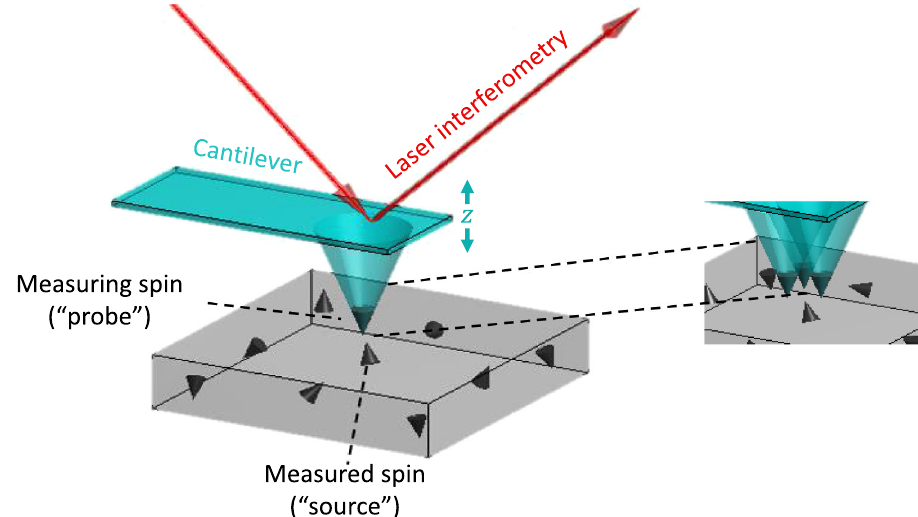
Fig. 1 A conceptual example of a magnetic near fi eld measurement system, analyzed using the principles of quantum measurements. A sample (gray) contains one or more spins to be measured (black cones). The measurement is performed on one of them at a time. The measurement device (tip) consists of spins attached to a vertically-bending cantilever (blue). The tip can contain a complex spin con fi guration, as shown in the inset on the right. Different spin con fi gurations represent different measurement setups, which are investigated to fi nd the optimal one. The measurement proceeds as follows: The tip is brought closed to the measured spin (source), such that it interacts with the tip ’ s spins (probe). The interaction exerts a force on the cantilever, yielding an (entangled) superposition of vertical displacements, each correlated to a different multi-spin state. Once the displacement of the cantilever is measured (usually with a laser interferometer 120 – 123 ), the system ’ s state collapses to a certain cantilever displacement and multi-spin state, and its state is known from the measured value of the displacement. We de fi ne the measurement precision by how precisely the z -magnetization of the source spin is obtained from the measured